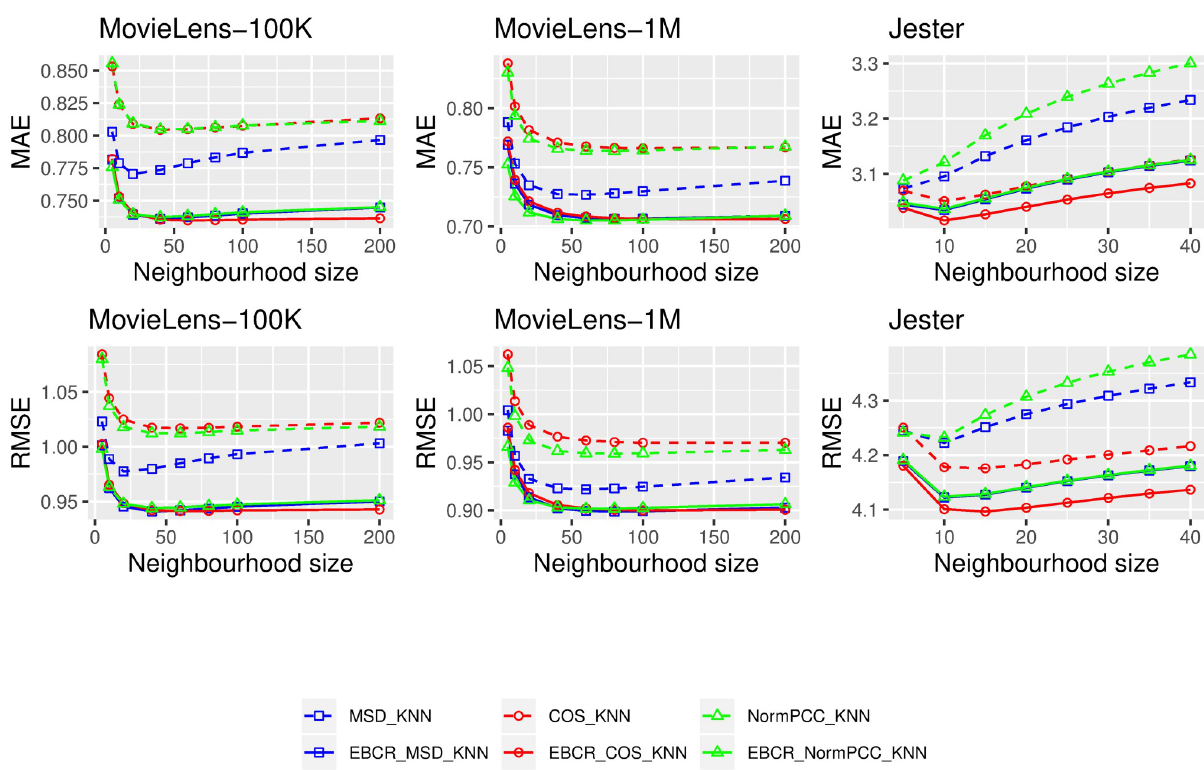
Fig 2. Comparisons of original similarity measures (i.e. dashed curves) with their variants integrating EBCR ratios (i.e. solid curves with the same colour) on three benchmark datasets: MovieLens-100K, MovieLens-1M and Jester.